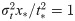
Results are robust to additional complexities including cell division.(A, B) Green solid curves show slices from Fig 2 with K = 10 while black dashed line shows unregulated limit σt2x*/t*2=1. We see that regulation can reduce timing variance even with bursts in activator production of mean size b (A, cyan and magenta dashed), initial Poisson noise in repressor number (B, green dashed), or steady state k/μ in regulator dynamics (blue) unless it approaches regulation threshold K (red). (C) Mean dynamics of activator model (solid) and repressor model (dashed) in which cell division occurs at time t¯d on average. Abrupt reductions in molecule numbers are smoothed by noise in td and by binomial partitioning of molecules. (D) Timing variance approaches that with no division (dashed) within experimental division region (gray). In A and B, parameters are as in Fig 2. In C and D, parameters are x* = 15, 〈a〉/x* = 〈r〉/x* = 10, and H = 3, with kt*, μt*, and K set to optimal values (Fig 2) and t¯d and σd set to experimental values. In all cases, α is set to ensure that mean threshold crossing time t¯ equals t*.